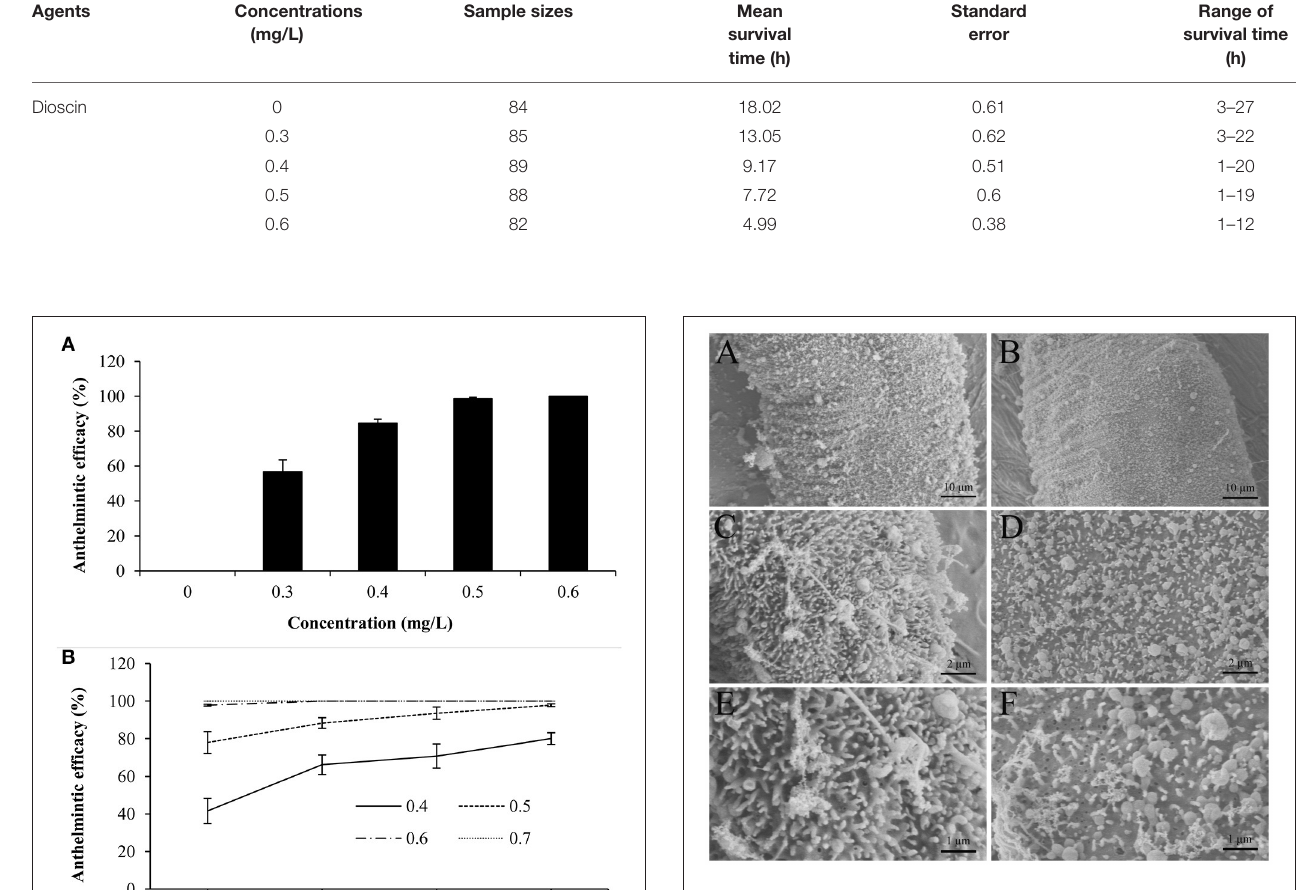
FIGURE 5 | Scanning electron microscopy (SEM) of Gyrodactylus kobayashii exposed to dioscin. Control group: worms exposed to 0.06% DMSO for 12h (A,C,E) , treatment group: worms exposed to 0.3 mg/L dioscin for 12h (B,D,F)